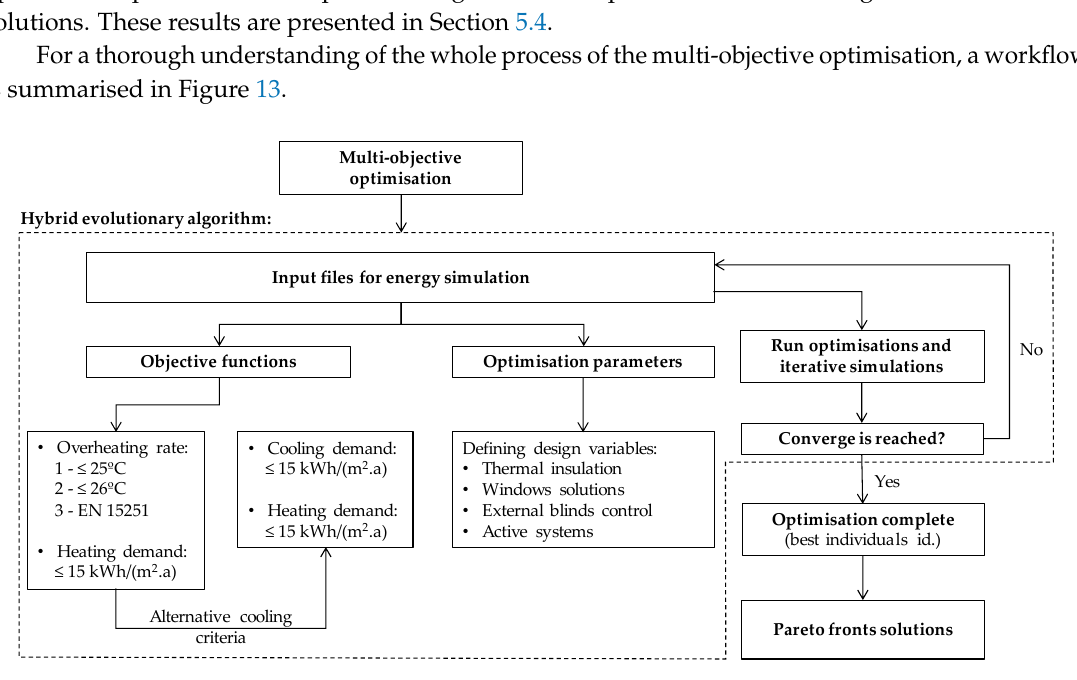
Figure 13. Multi-objective optimisation process.